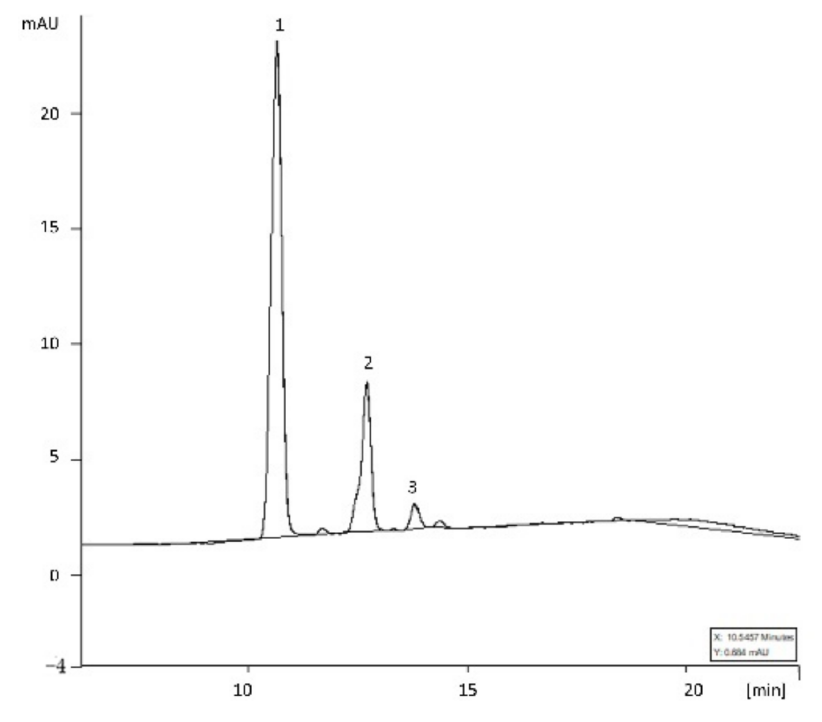
Figure 2. HPLC chromatograms of raspberry pomace extract recorded at 525 nm. Peaks: 1—cyanidin- 3-O-sophoroside; 2—cyanidin-3-O-glucoside;